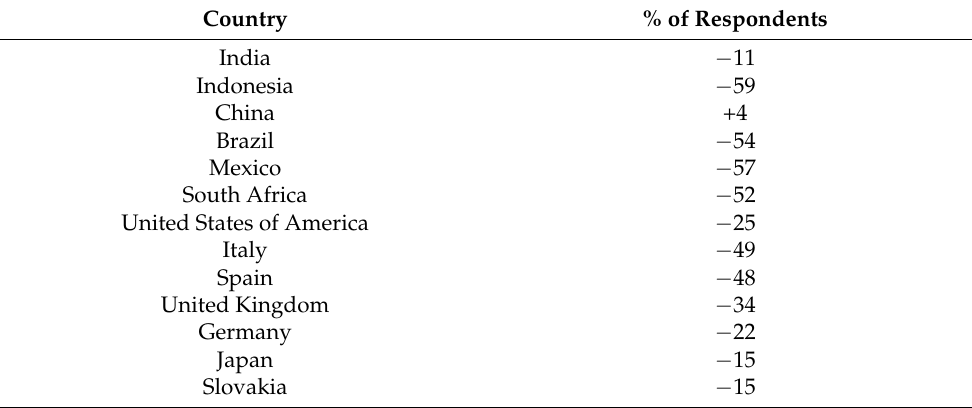
Table 7. Comparison of planned reductions in expenses.